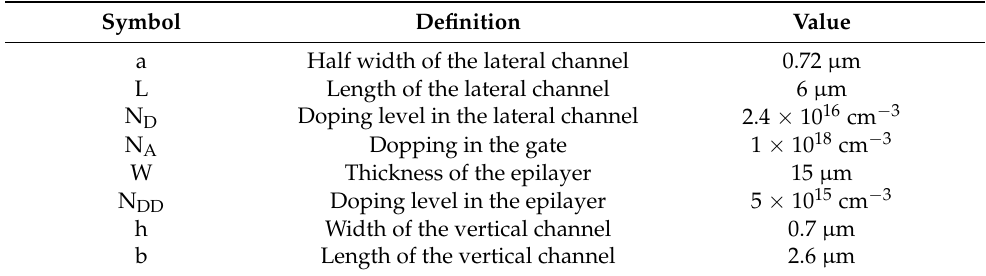
Table 1. Geometrical and Doping parameters values used in the